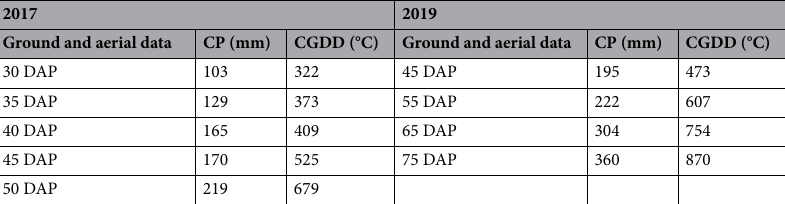
Table 3. Days and times of ground and aerial data collection in 2017 and 2019. Dates for the UAV flights with the RGB camera, and ground data measurement of leaf area index (LAI) and lateral growth (LG) of peanut plots. For each date, the cumulative precipitation (CP) and cumulative growing degree days (CGDD) from planting to each day after planting (DAP) have been